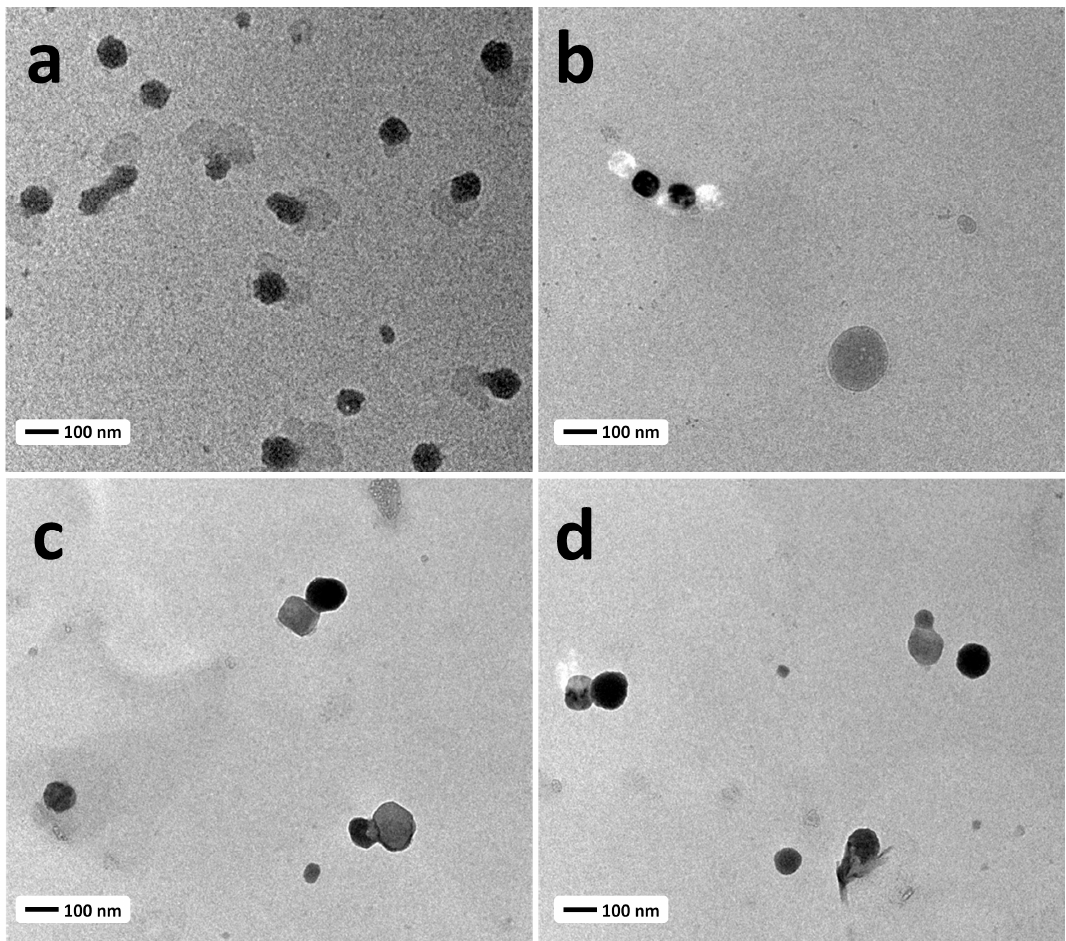
Figure 2. Transmission electron microscopy images of ( a ) Free liposomes, ( b ) Lipo-CDDP, ( c ) Lipo- DADS, and ( d ) Lipo-CDDP/DADS.